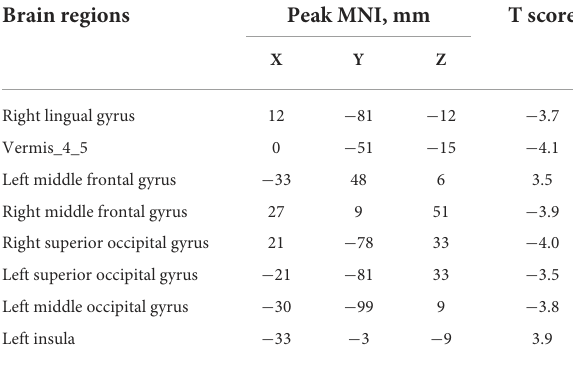
TABLE 2 Regional homogeneity differences between healthy controls and patients with